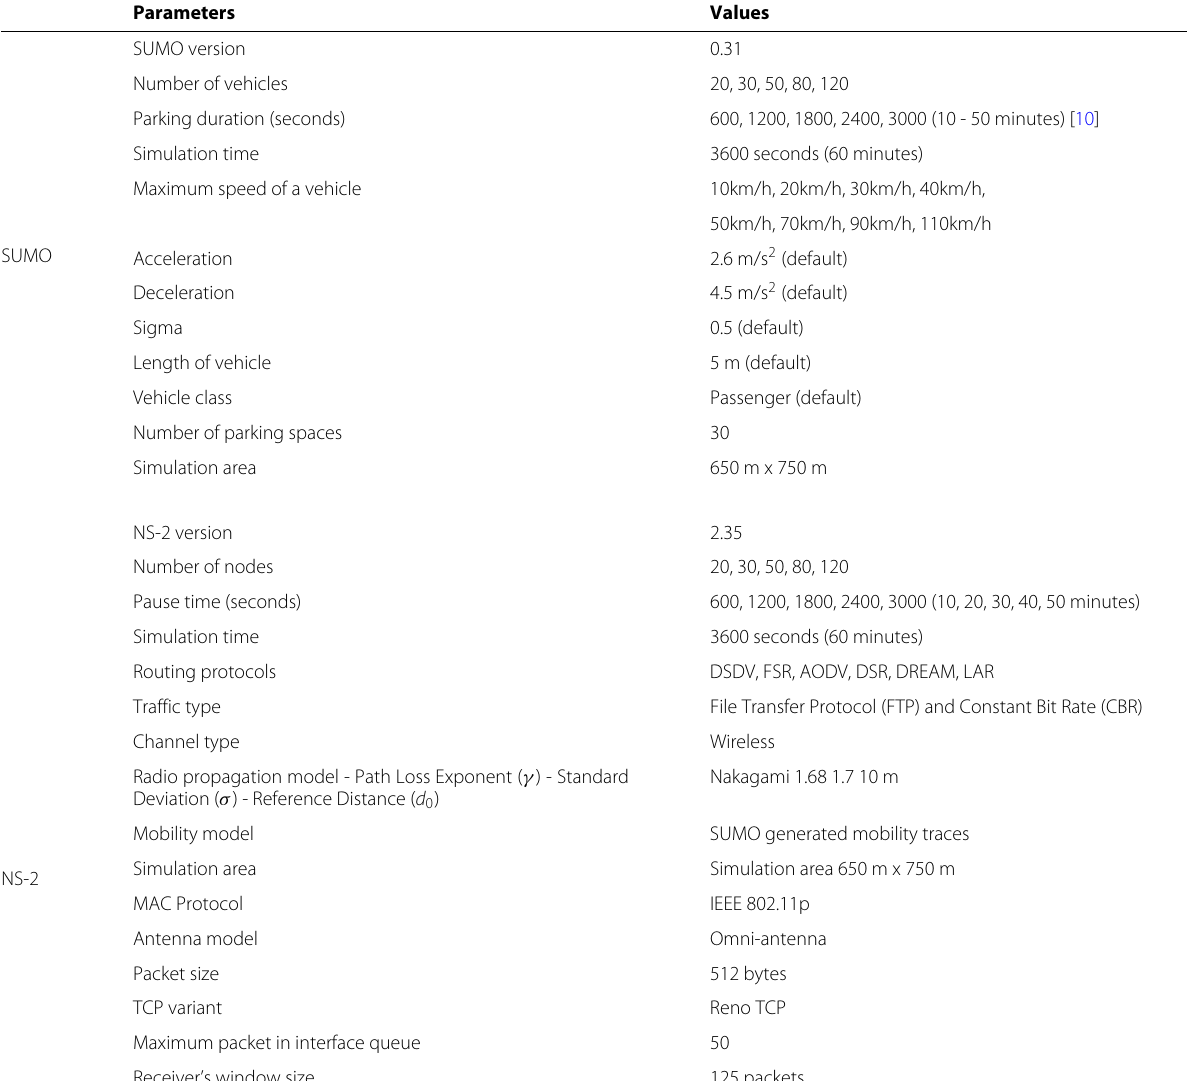
Table 2 SUMO and NS-2 Parameters Considered in Simulations